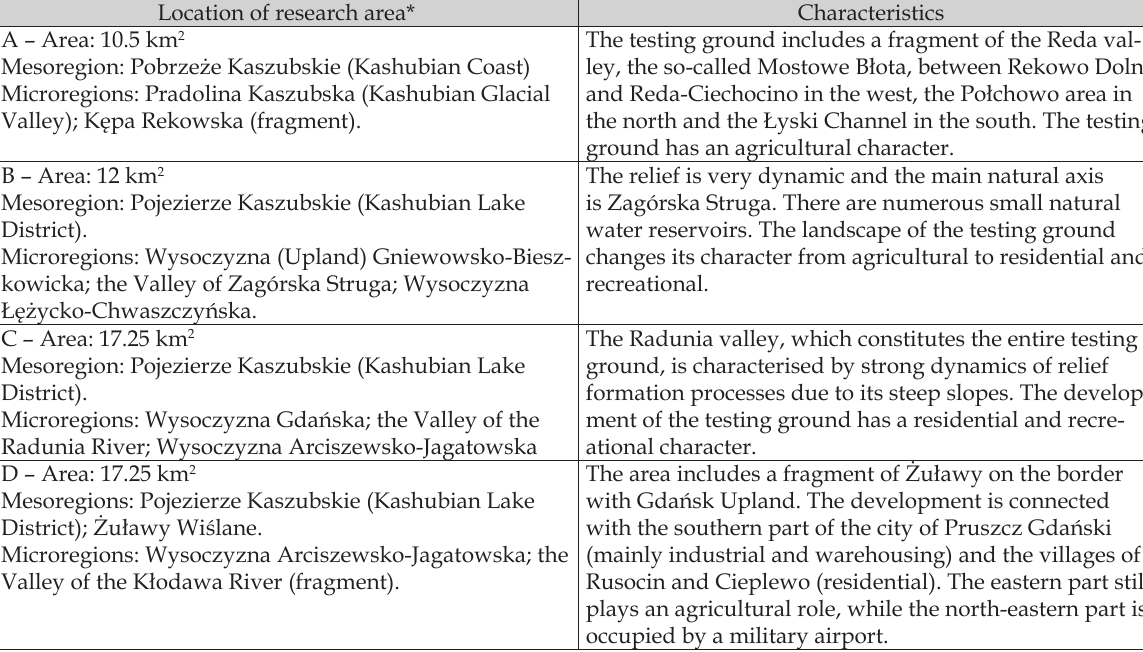
Table 3. Characteristics of surface area, location and land cover of the selected testing grounds. location of research area*